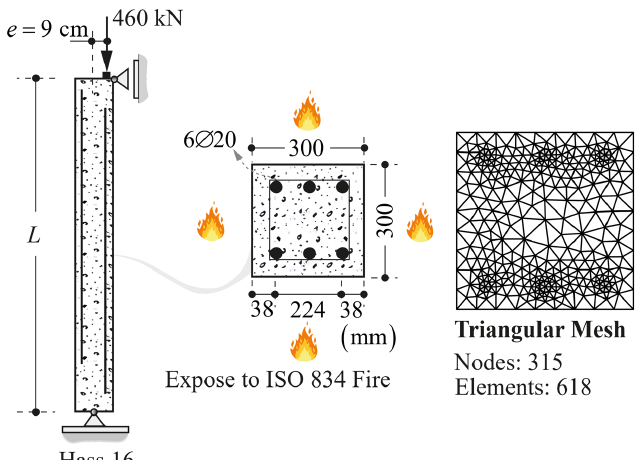
Figure 7. Characteristics of the structural model and details of the cross-section of the square column of reinforced concrete with eccentricity subjected to